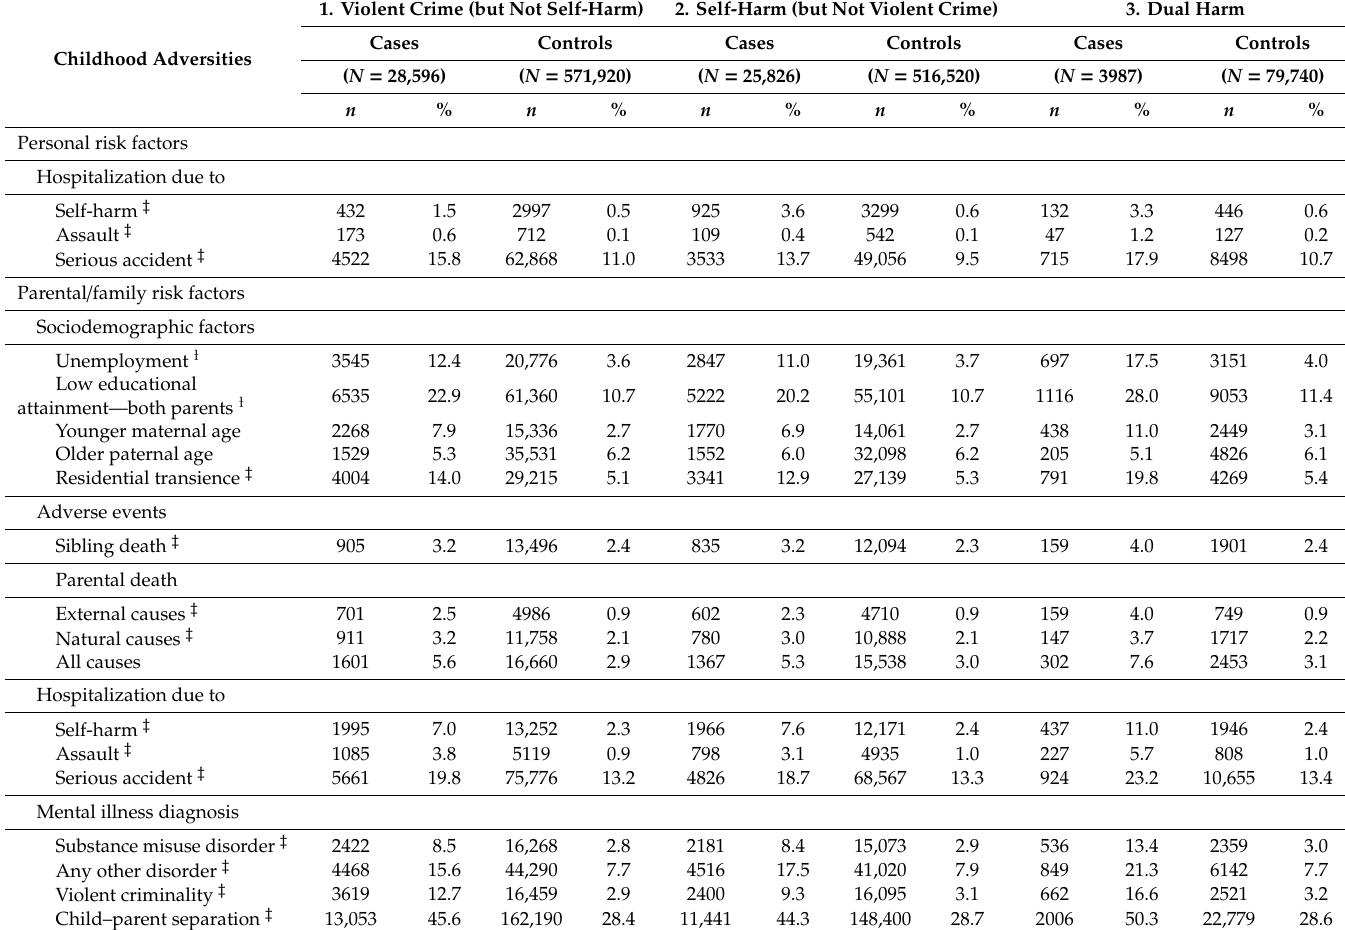
Table 1. Exposure prevalence of adverse childhood experiences among cases vs. controls for the 3 behavioral outcome